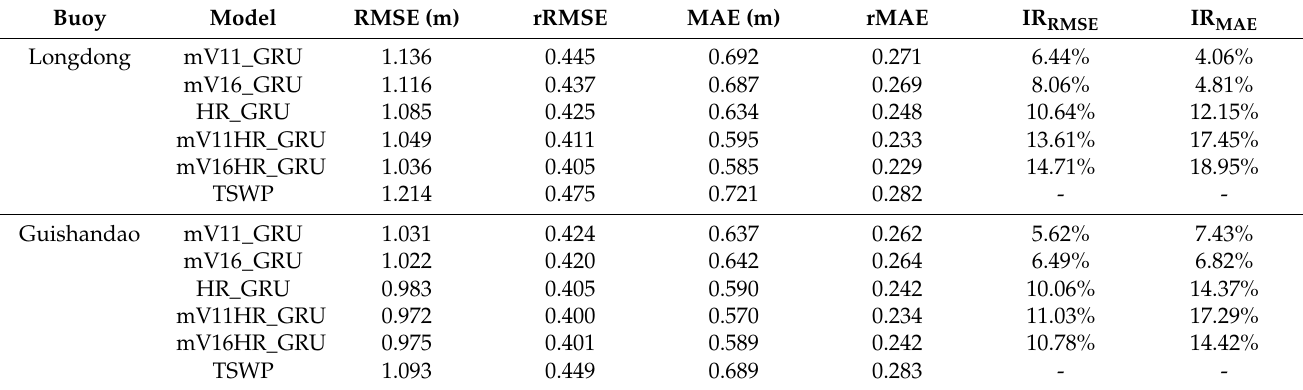
Table 5. Averages of the RMSE and MAE and their IR for a lead time of 1 to 6 h at the Longdong and Guishandao buoys. Buoy Model RMSE (m)